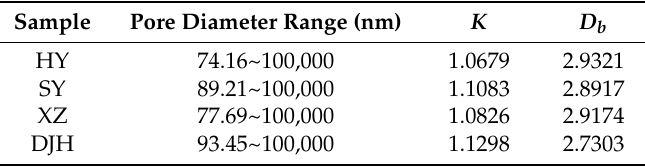
Table 5. Calculated fractal dimensions of